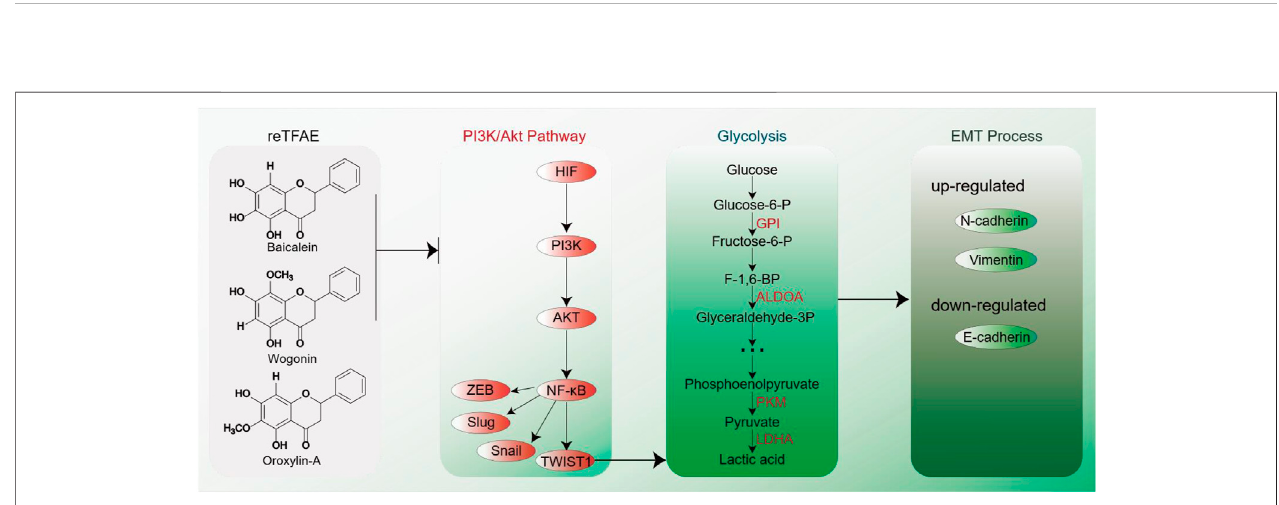
FIGURE5| EMTprocessinducedbyreTFAE.BaicaleinandwogonininhibitthePI3K/Aktpathway,therebyinhibitingTWIST1,whichinhibitstheglycolysispathway and inhibits the EMT process of A549 cells.